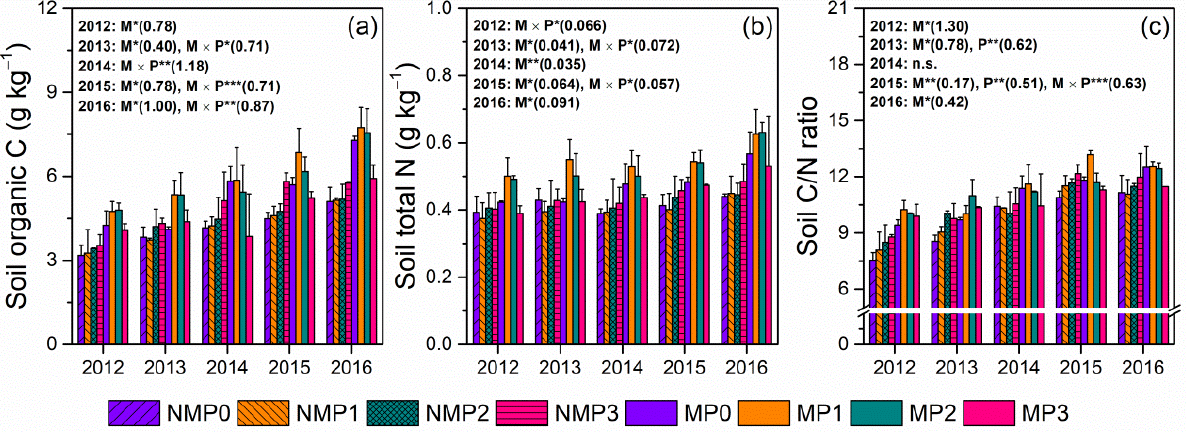
Figure 1. Soil organic C (SOC, a ), soil total N (TN, b ), and soil C/N ratio ( c ) under no film mulching (NM) and film mulching (M) at four P levels (P0, P1, P2, and P3). * p ≤ 0.05, ** p ≤ 0.01, and *** p ≤ 0.001. Numbers in brackets are LSD at p = 0.05. Error bars are standard deviations. Film mulching significantly increased SOC, and a linear and quadratic polynomial model well-fitted SOC with P application level as the independent variable under no film mulching and film mulching, respectively (Figure 2). The highest SOC (6.14 g kg − 1 ) occurred under film mulching plus 11.9 kg ha − 1 applied P, with higher P levels not increas- ing SOC.